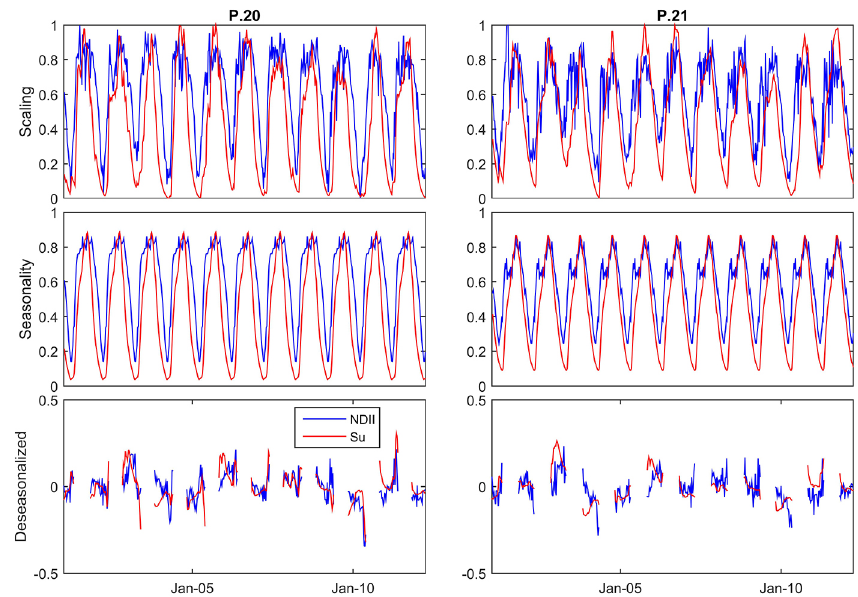
Figure 7. Scaled time series, seasonality, and deseasonalized (dry season) time series of the 8-day averaged NDII values compared to the 8-day averaged simulated root zone moisture storage ( S u ) in the Nam Mae Rim sub-basin at P.20 (Chiang Dao) and P.21 (Ban Rim Tai) runoff stations. The coefficients of determination ( R 2 ) of the deseasonalized NDII and S u are 0.32 and 0.18, respectively, for P.20 and P.21. For the results of all the eight sub-basins, please refer to the